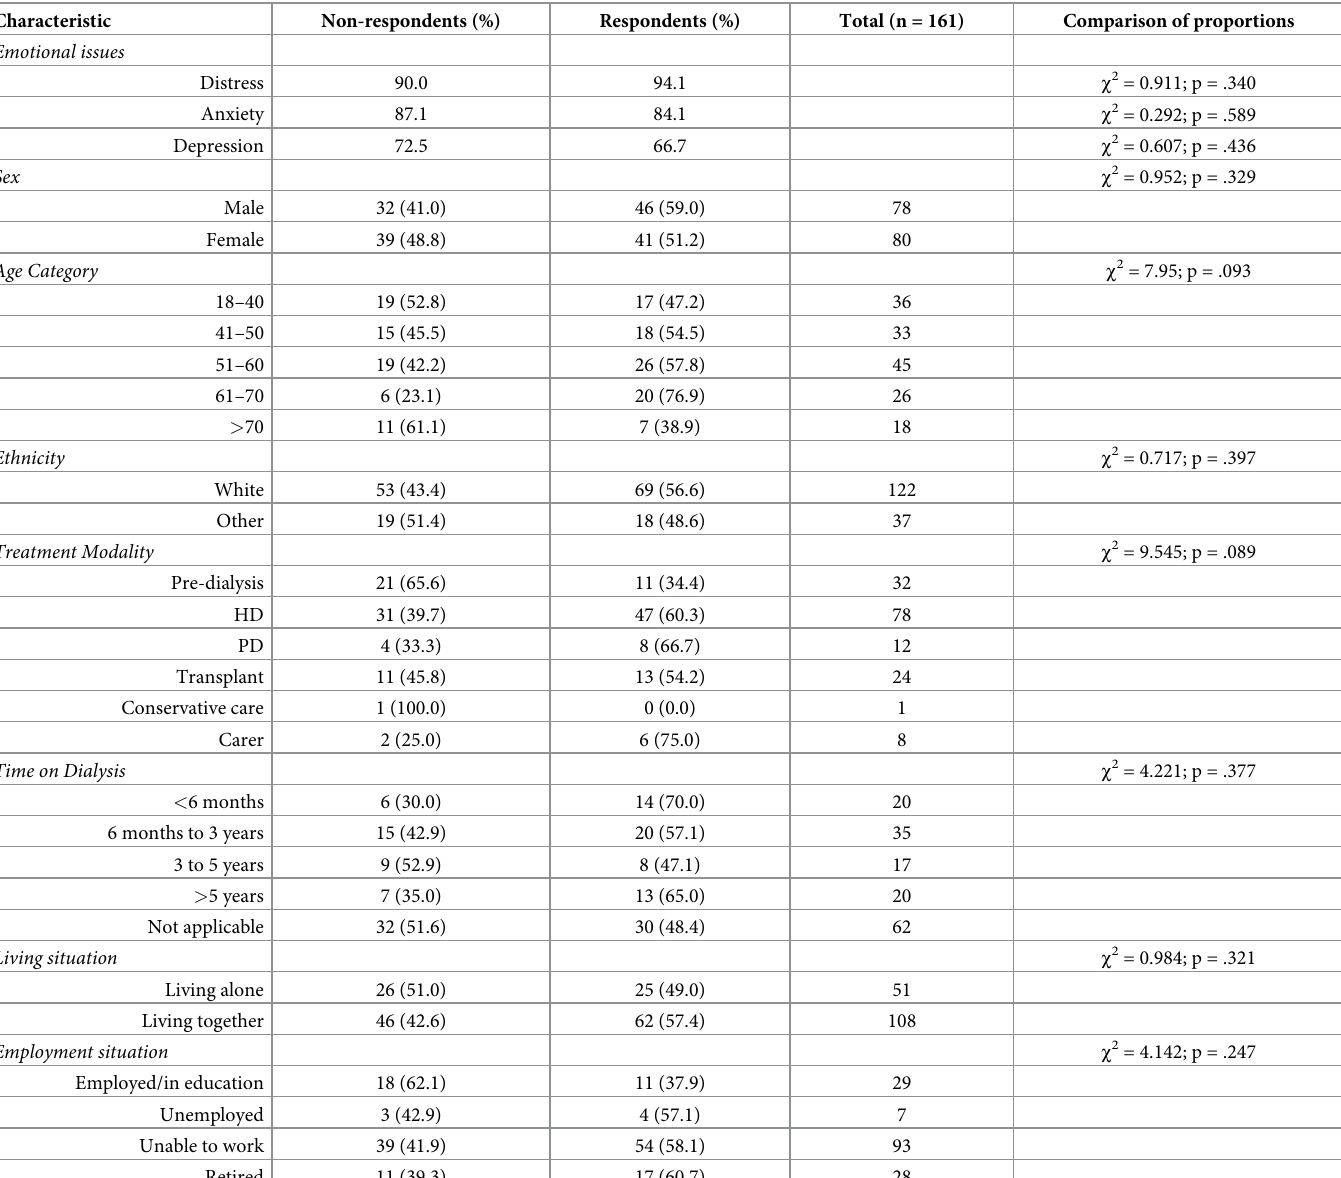
Table 1. Comparison of characteristics of post-intervention non-respondents and respondents.